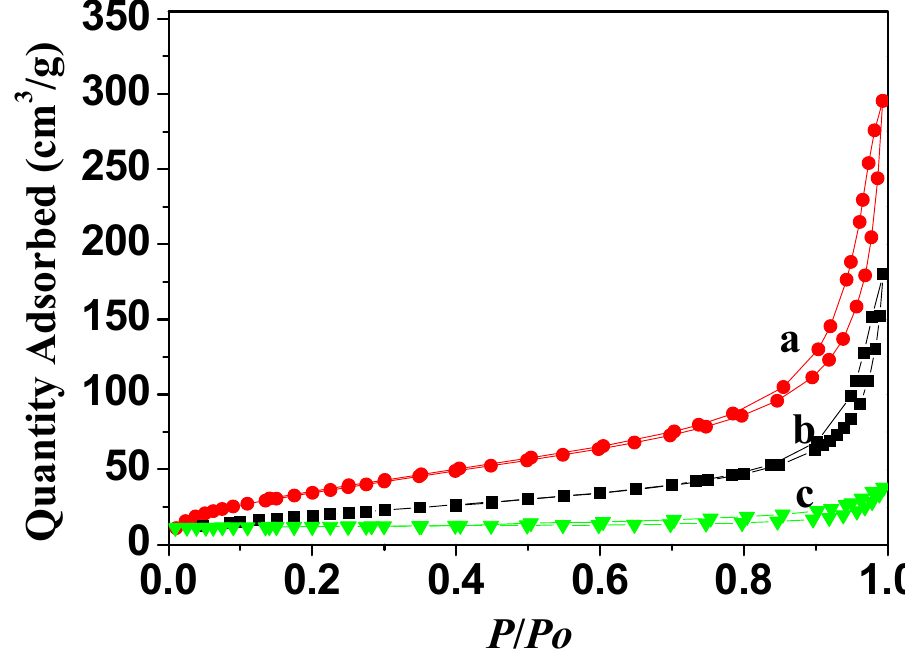
Figure 5. BET spectrum of the ( a ) VulcanXC-72R, ( b ) MoS 2 /C composite, and ( c ) MoS 2 . The amount of C may have effects on the ORR catalytic performance of the